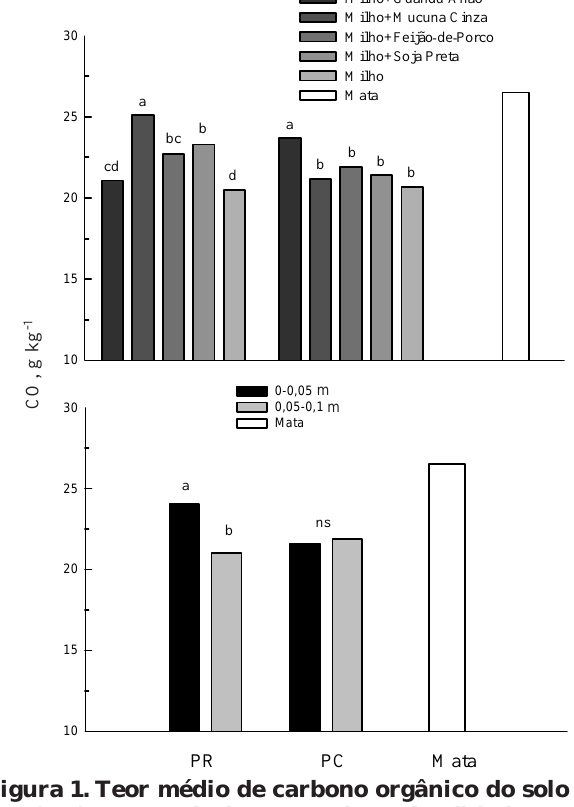
Figura 1. Teor médio de carbono orgânico do solo (CO) na camada de 0–0,1 m de profundidade nos sistemas de cultura com preparo reduzido (PR) e convencional (PC) e na mata nativa. Para comparar as profundidades (0–0,05 e 0,05– 0,1 m), foi calculada a média dos cinco sistemas de culturas em cada sistema de preparo. Letras minúsculas diferentes indicam diferença significativa (Duncan a 5